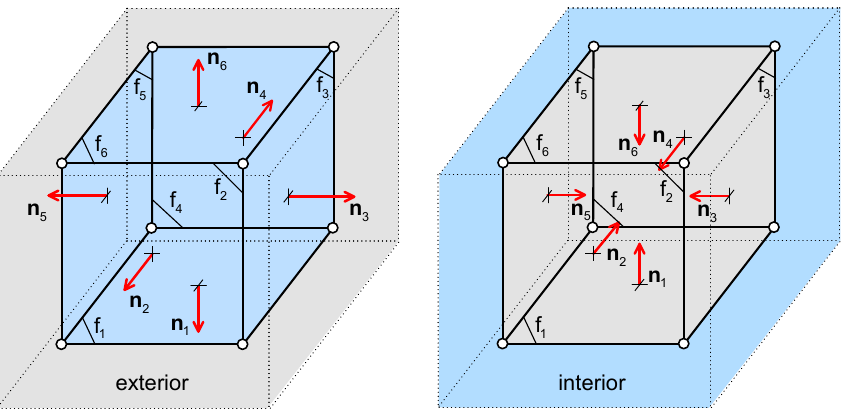
Figure 7. Oriented cells with polyhedral boundary surfaces.